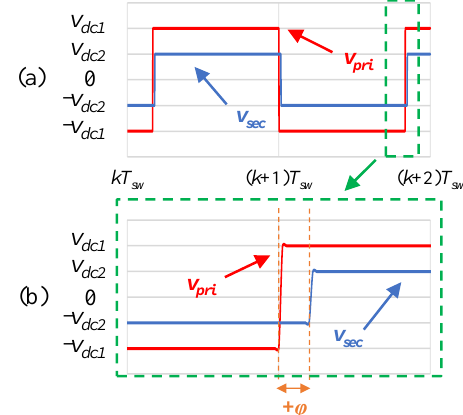
Figure 6. Voltage waveforms in the primary and secondary sides of the HF transformer using SPS modulation: (a) During a full cycle; (b) In detail.